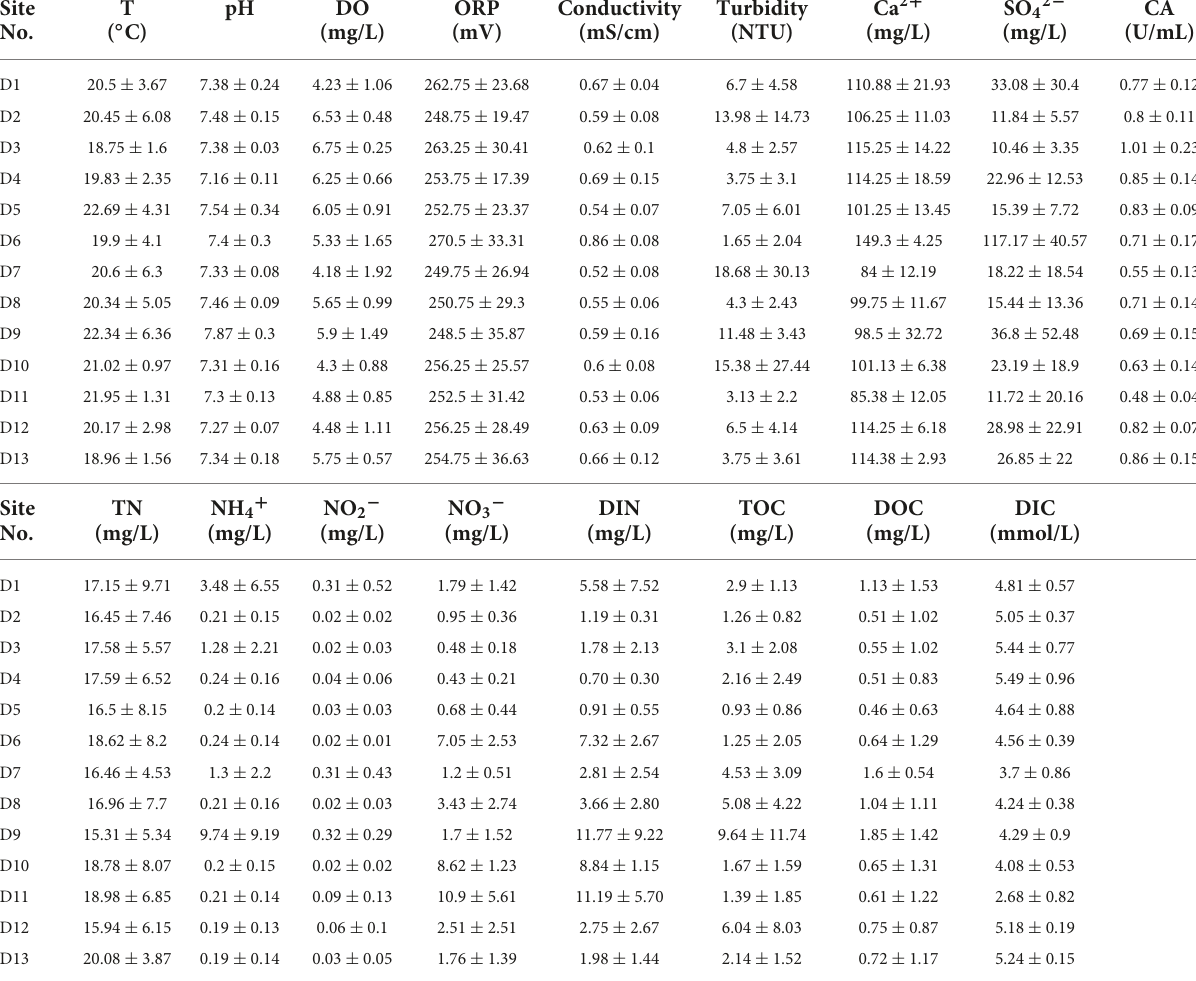
TABLE 2 Basic physicochemical properties and CA activity at the sampling sites of the Huixian karst groundwater. Site